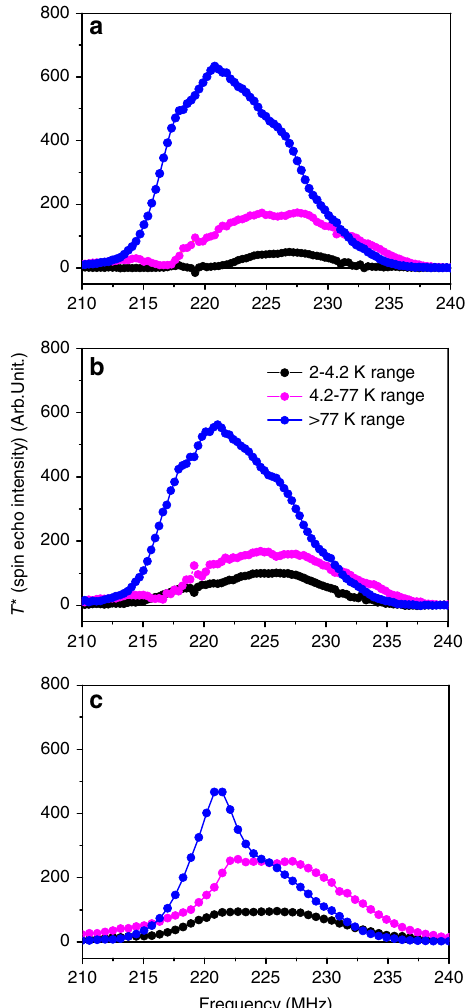
Figure 3 | Temperature differential ferromagnetic nuclear resonance 59 Co spectra. ( a ) CoS, ( b ) CoDTiS and ( c ) CoCNTA. Spectra ( a , b ) have similar shapes showing that the crystallographic structures of the samples are similar. Spectra c are very different from spectra a and b . The sample in c contains a much larger number of small f.c.c. particles (line at 222MHz) than the samples in a , b